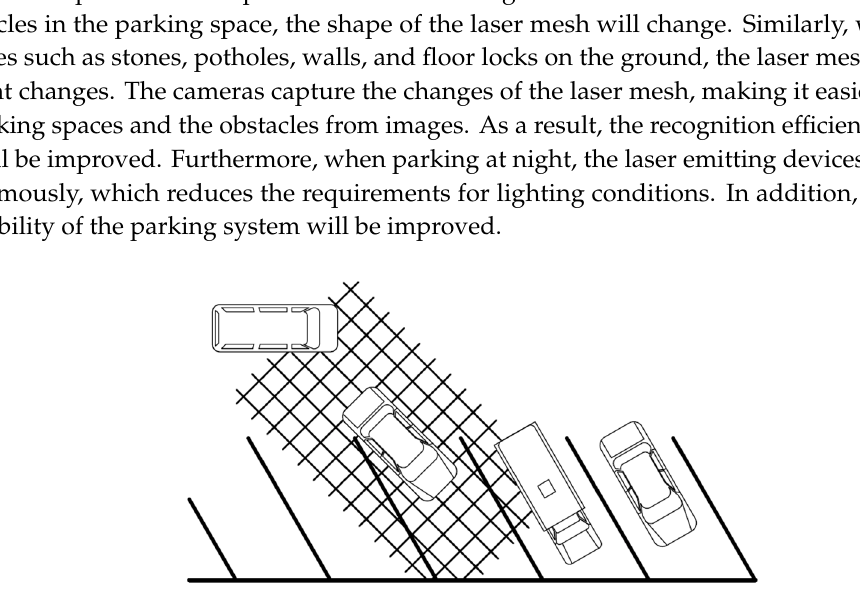
Figure 2. System schematic.